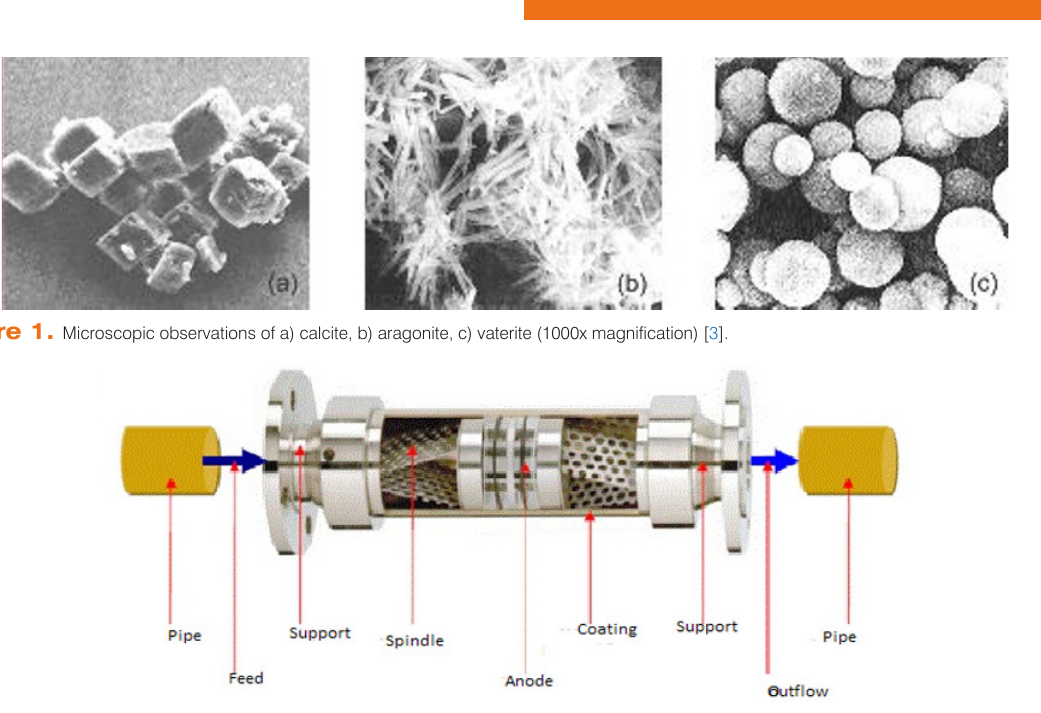
Figure 2. Electrogalvanic device [